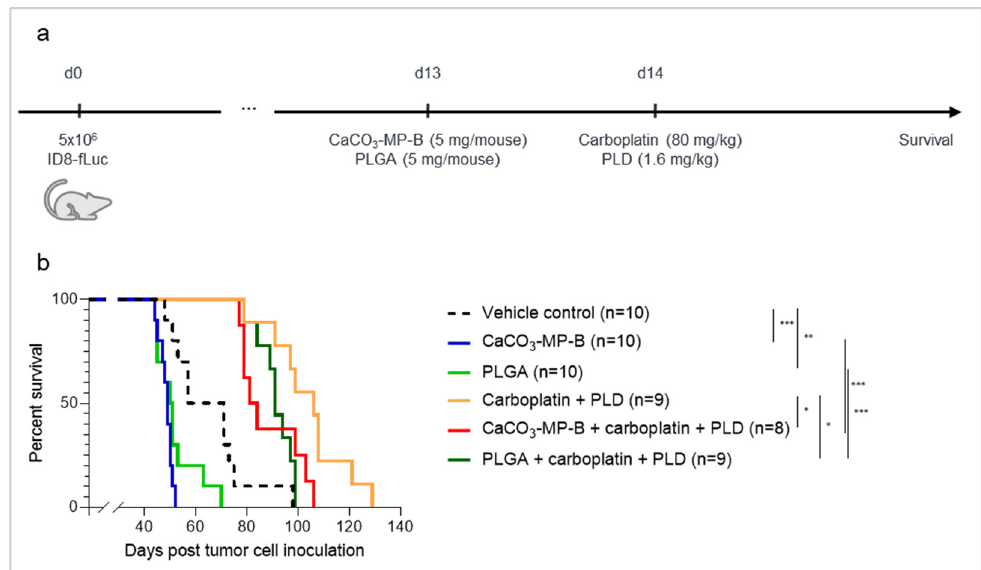
Figure 6. Experimental set-up of the experiment ( a ) with corresponding Kaplan–Meier survival curve ( b ) of mice injected with vehicle control, 5 mg of CaCO 3 -MP-B or 5 mg PLGA on day 13 and/or 80 mg/kg carboplatin with 1.6 mg/kg PLD on day 14 post tumor cell inoculation. Animals experiencing severe short-term toxicities (severe weight loss, diarrhea and cachexia) as a reaction to the chemotherapy in the first ten days after treatment administration, were excluded from all further data analysis. The current data are obtained from the same experiment as the data that are found in Figure 3. ( b ): As a single treatment, CaCO 3 -MP-B and PLGA have a shorter survival compared with vehicle control ( p adj = 0.0007 and p adj = 0.0095, respectively). This hyperproliferation effect of CaCO 3 -MP-B and PLGA remains present in combination with carboplatin and PLD compared with carboplatin and PLD alone ( p adj = 0.0325 and p adj = 0.0191, respectively). PLGA: polymer poly (lactic-co-glycolic acid), PLD: pegylated liposomal doxorubicin. Degree of significance: p adj <0.05 (*), p adj < 0.01 (**), p adj < 0.001 (***).